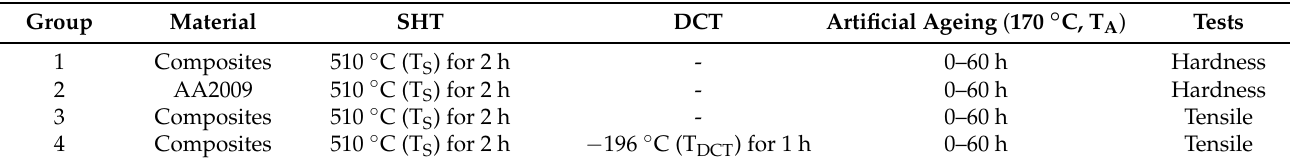
Figure 1. Schematic showing the heat treatment route. Table 2. Experimental